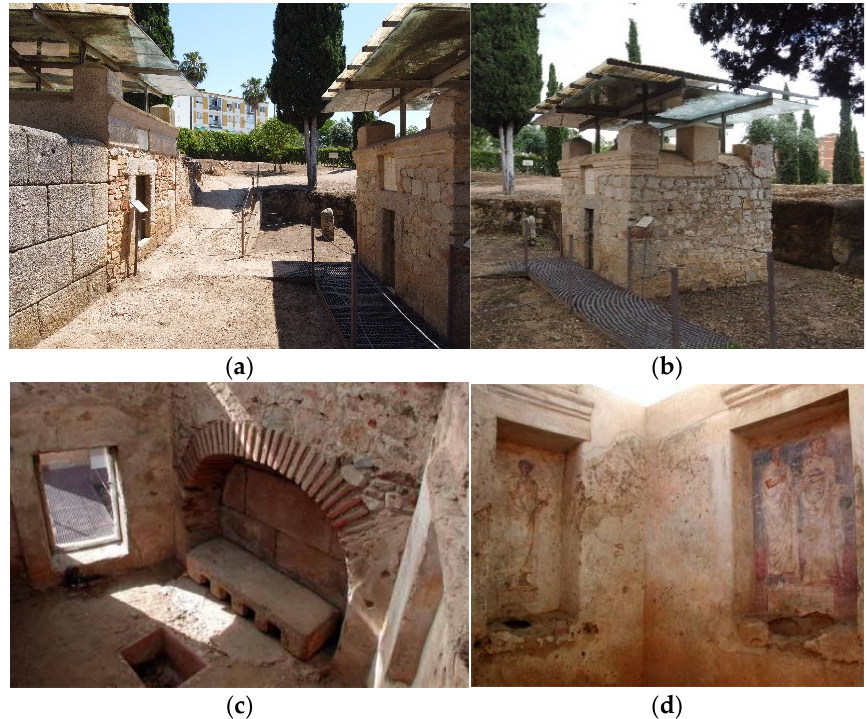
Figure 1. Current state of the buildings under study. ( a ) Outside view of the buildings; ( b ) outside of the Voconios building; ( c ) inside of the Julios building. Here we can see the niches where the urns containing the cremated remains of the Julios family were deposited. ( d ) Inside of the Voconios building. Remains of the Roman paintings of the members of the family who were buried there are preserved.